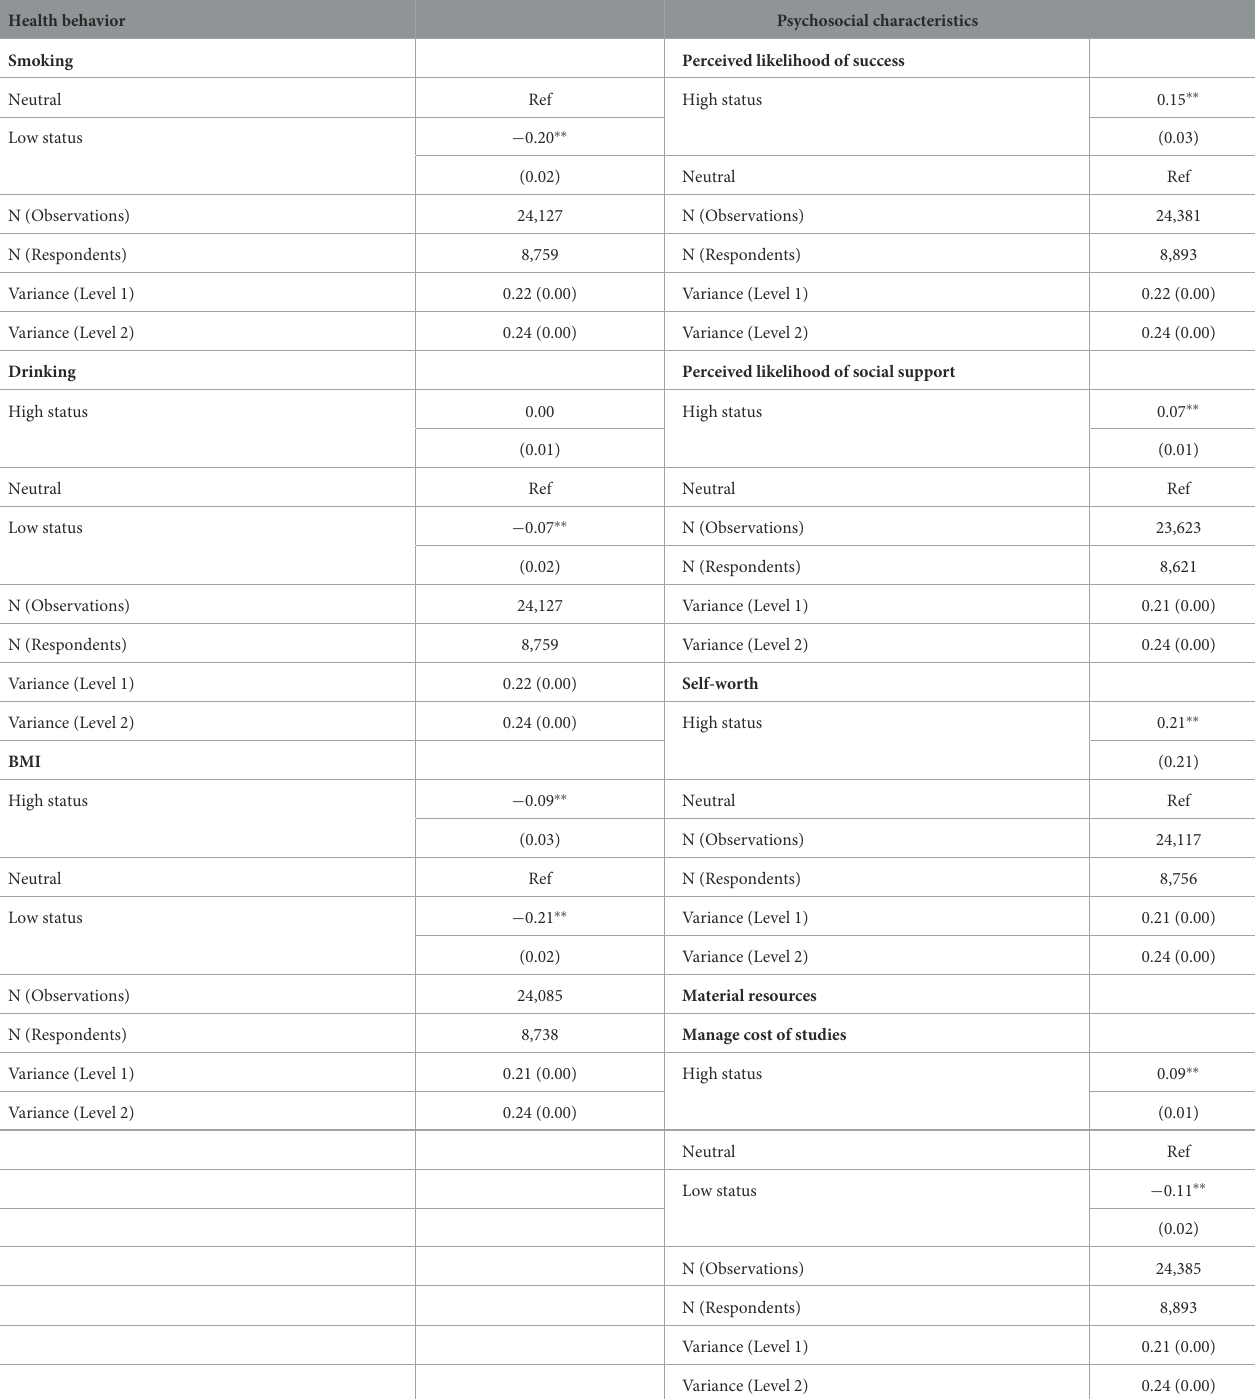
TABLE 7 Multilevel linear regression models for indirect effects of parents’ occupational status via health behavior and psychosocial resources on students’ self-rated health (separate